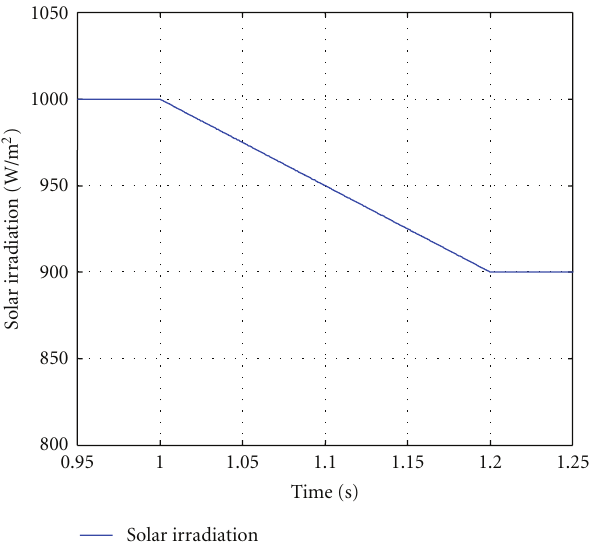
Figure 14: Slow change of irradiation from 1000 W/m 2 to 900W/m 2 .